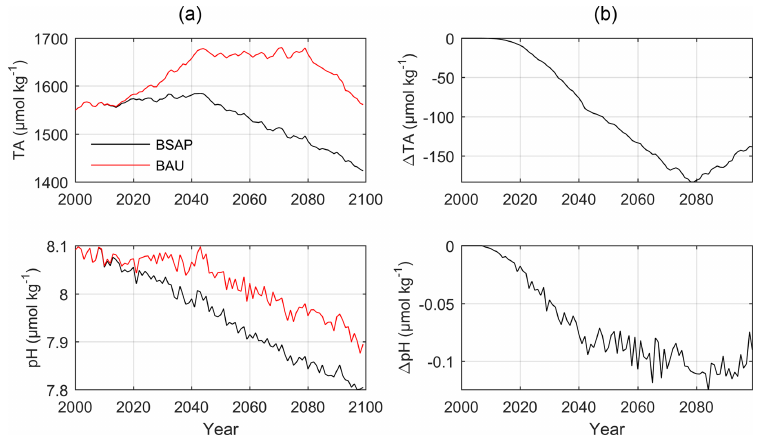
Figure 9. (a) Simulated annual mean surface water TA and pH in sub-basin 9 (GS) according to the BSAP (black lines) and BAU (red lines) nutrient load scenarios. (b) Differences between the BSAP and BAU scenarios. Table 6. Input of Fe oxides and simulated S burial and TA efflux averaged for the period 2011–2050 under a range of